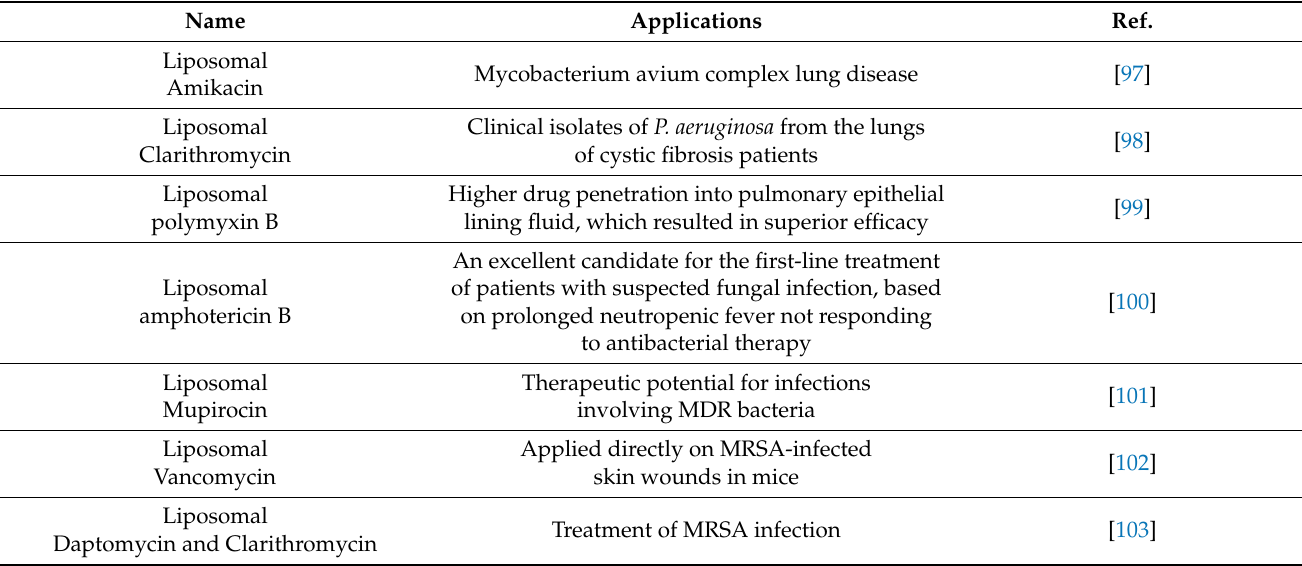
Table 2. Applications of antibiotic liposomes in the antibacterial